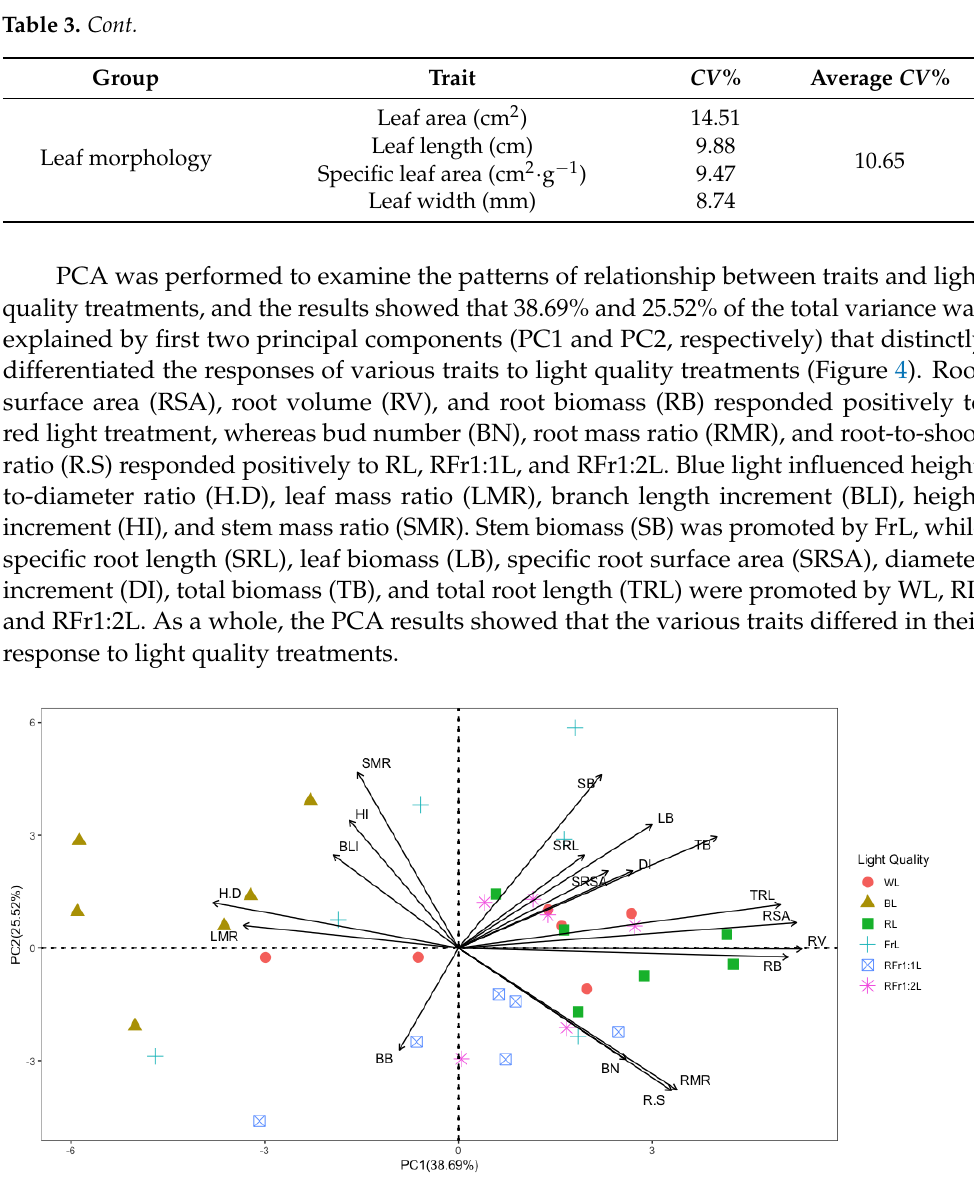
Figure 4. Principal Component Analysis (PCA) plot showing the patterns of trait responses to light quality treatment: HI, height increment; DI, diameter increment; H.D, height-to-diameter ratio; BLI, branch length increment; LB, leaf biomass; SB, stem biomass; RB, root biomass; TB, total biomass; LMR, leaf mass ratio; SMR, stem mass ratio; RMR, root mass ratio; BB, bud biomass; BN, bud number; R.S, root-to-shoot ratio; RV, root volume; RSA, root surface area; TRL, total root length; SRSA specific root surface area; SRL, specific root length.